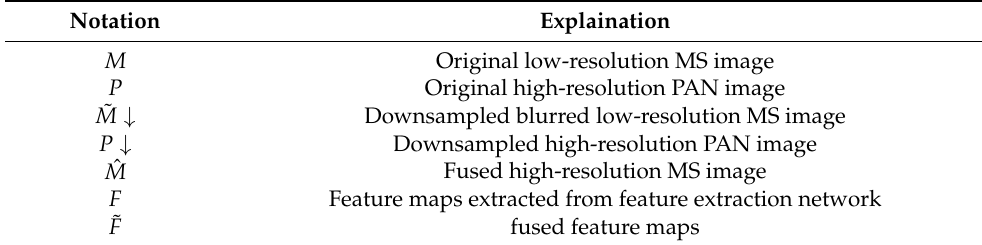
Table 1. The notations in the following